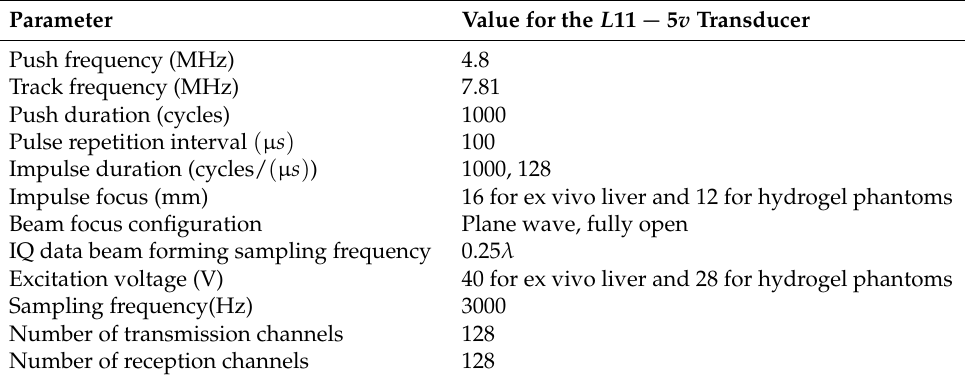
Table 3. SWEI acquisition parameters for L 11 − 5 v Verasonics